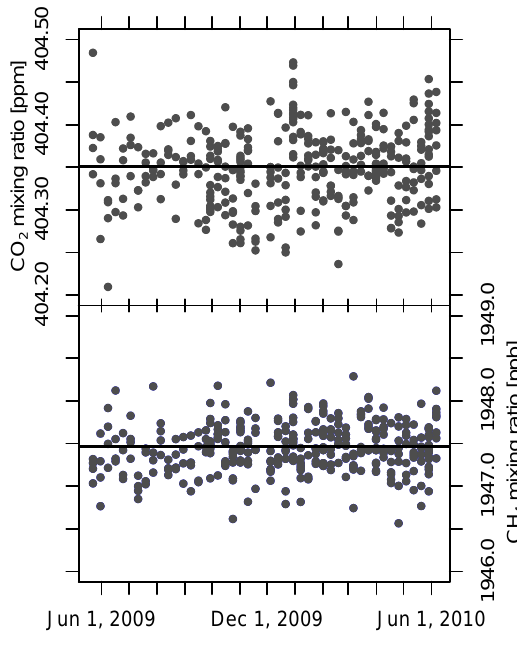
Fig. 5. Target tank time series (black line represents the